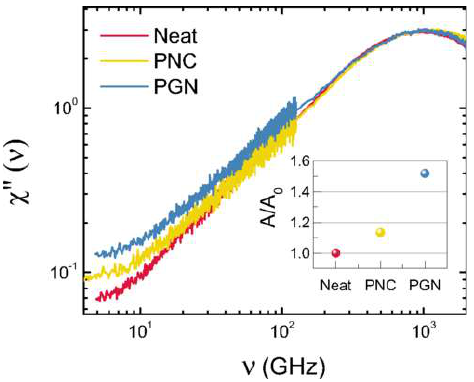
Fig. 5 . Neutron scattering data presented as susceptibilities (T = 300 K, summed over all Q values, combined BASIS (SNS) and CNCS (SNS) measurements). The inset shows the normalized QENS area under the curve of a neat polymer vs. the polymer nanocomposite (PNC) and the polymer grafted to nanoparticles (PGN). Reprinted with permission from [15]. Copyright 2017 by the American Physical